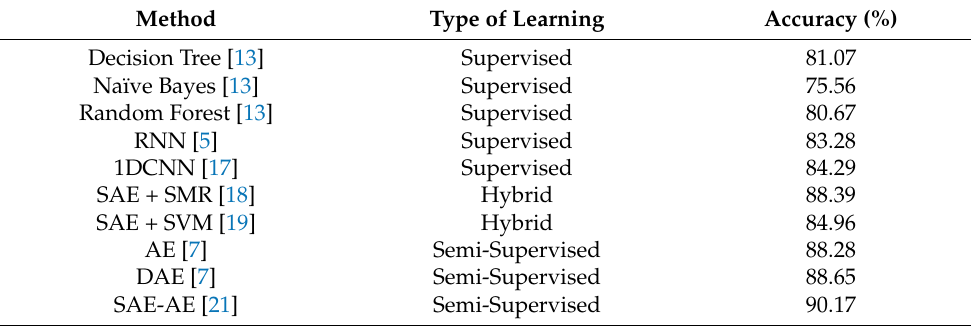
Table 2. A variety of methods used the accuracy of the NSL-KDD test